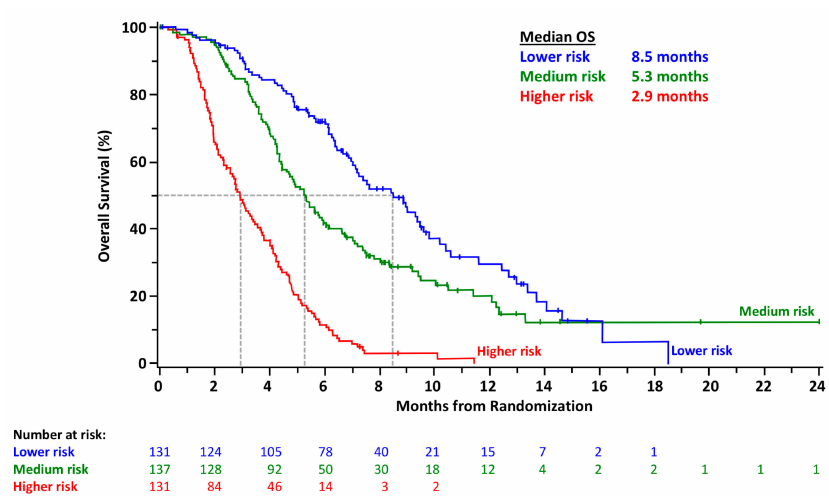
Figure 3. Kaplan-Meier survival curves showing overall survival probability stratified by risk group.